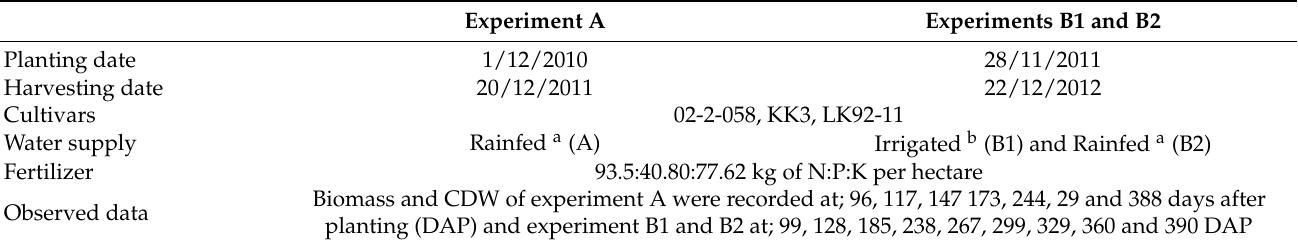
Table 1. Details of the field